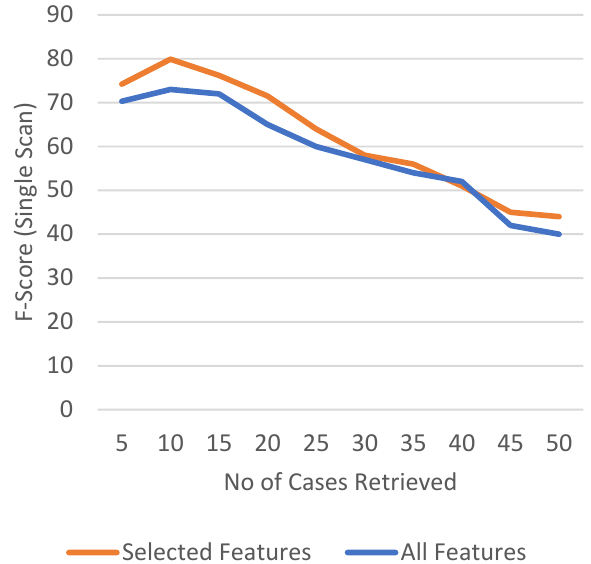
Figure 8. Comparison of selected features for single scan.